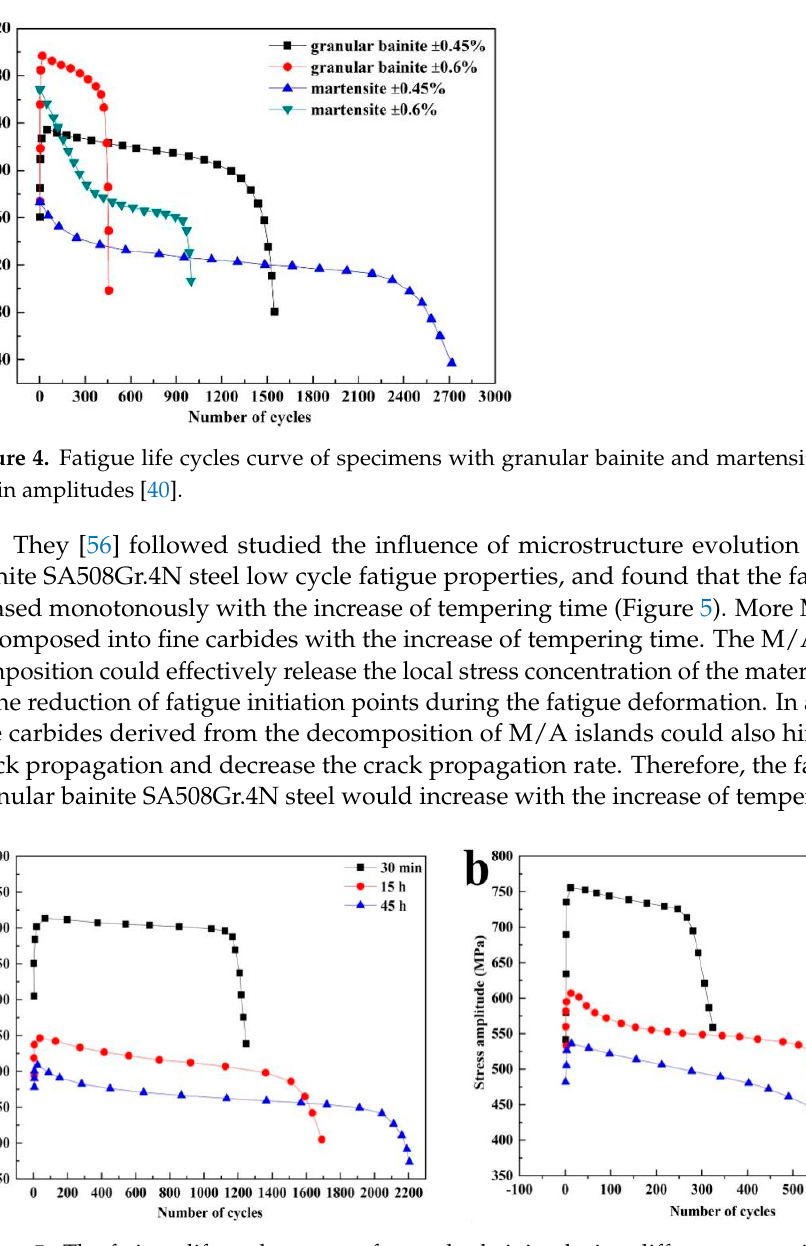
Figure 5. The fatigue life cycles curve of granular bainite during different tempering durations: ( a ) strain amplitude ± 0.45% and ( b ) strain amplitude ± 0.6% [56].